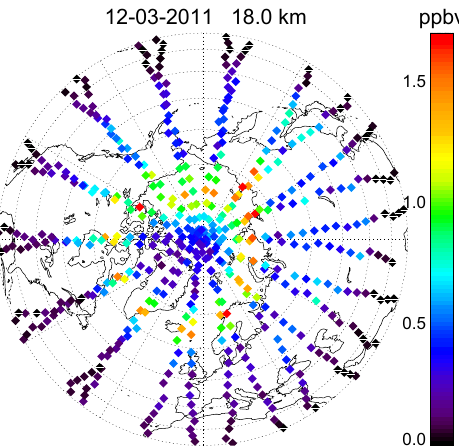
Figure 4. Chlorine nitrate measurements by MIPAS over the Arctic at 18km altitude on 12 March 2011. The “collar” of large mixing ratios surrounds the core area of the polar vortex where ClONO 2 values are lower. Figure from von Clarmann et al. (2009), used un- der CC Attribution 3.0